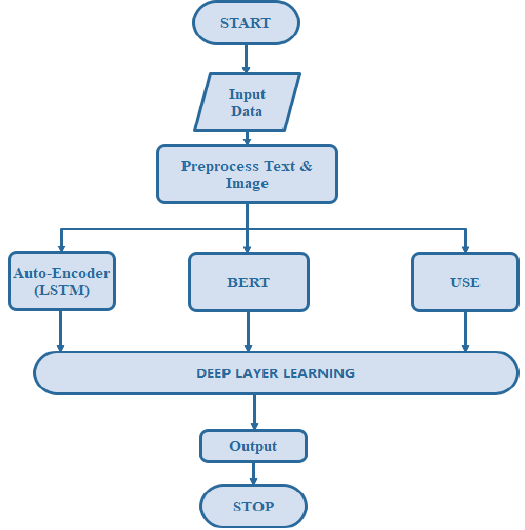
Figure 4. Flowchart of the proposed model.